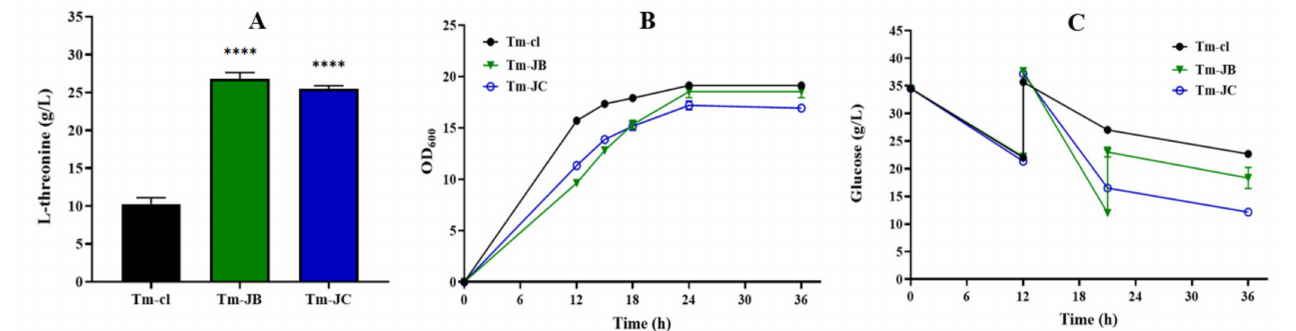
Figure 5. Dynamic regulation of rhtB and rhtC expression to improve L-threonine production. Strain Tm-cl containing the nonexpressed transporter as the control, rhtB , and rhtC was overexpressed in the strains Tm-JB and Tm-JC, respectively. ( A ) L-threonine titers were detected at 36 h of fermentation. ( B , C ) Glucose consumption and cell growth were monitored for 36 h of fermentation. All results were calculated with three ( n = 3) independent replicates. Error bars represent mean ± SEM. **** p < 0.0001.